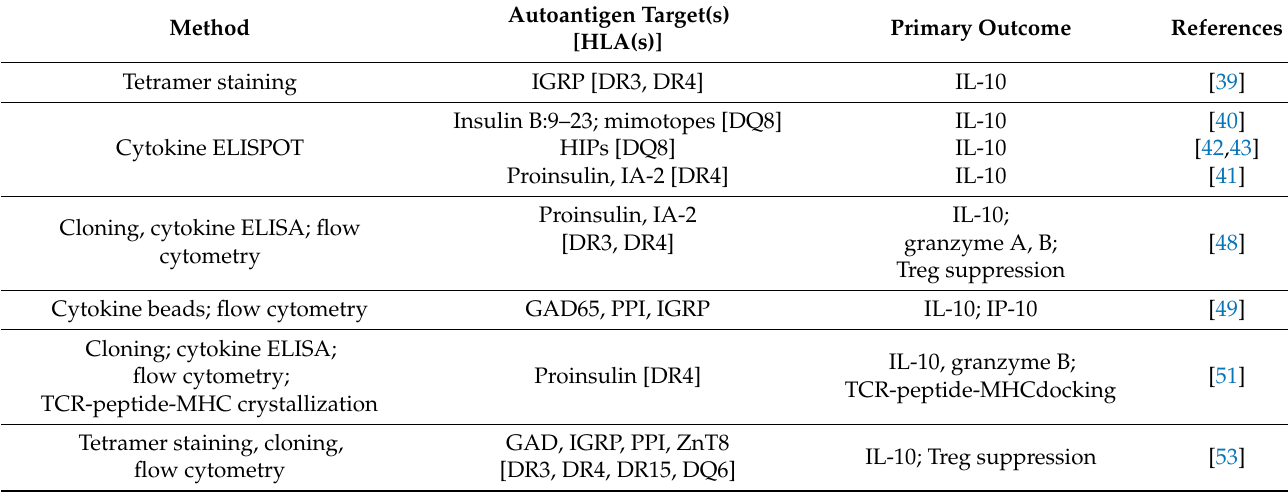
Table 1. Select antigen-specific Treg studies in human type 1